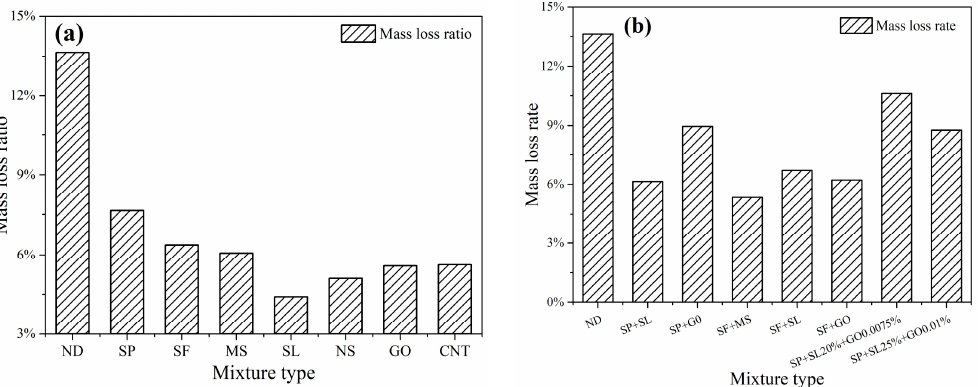
Figure 12. Mass loss rate of porous concrete with different admixtures after 300 times scattering: ( a ) single ad mixtures; ( b ) composite admixtures.